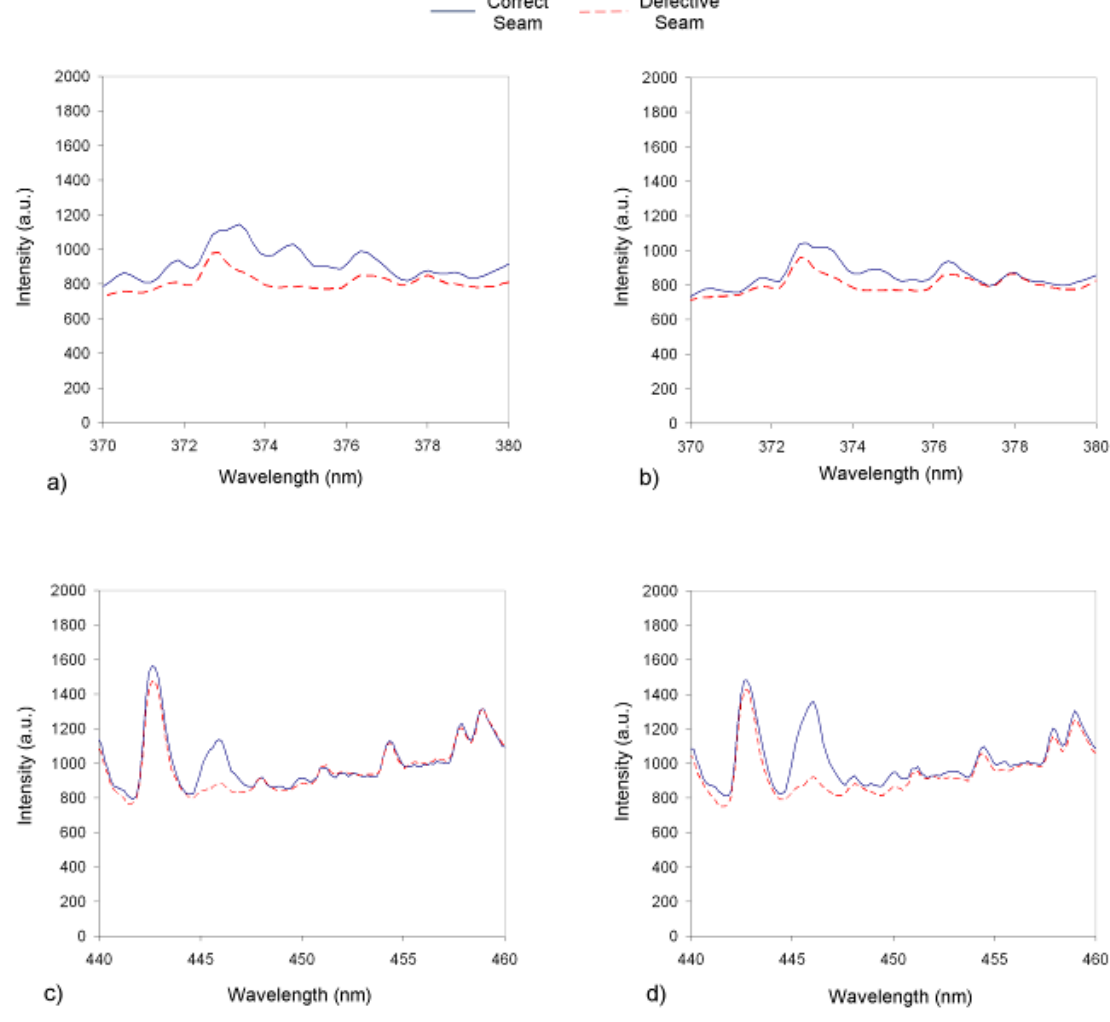
Figure 5. Comparison of spectra associated with correct and defective seams: a) and b) spectral band 375.03 for seams nº 1 and 2; c) and d) spectral band 446.07 for seams nº 1 and